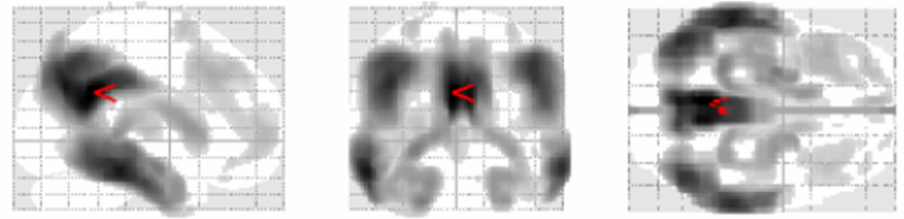
Figure 2. Sample output of SPM12. A group-wise comparison was performed on FDG-PET scans of AD patients and healthy controls, and the results were compared by t -testing. Regions of statistically significant differences between the groups ( p = 0.05 with family-wise error adjustment) are shown as dark clusters on the white glass brain. Red arrow points to the global